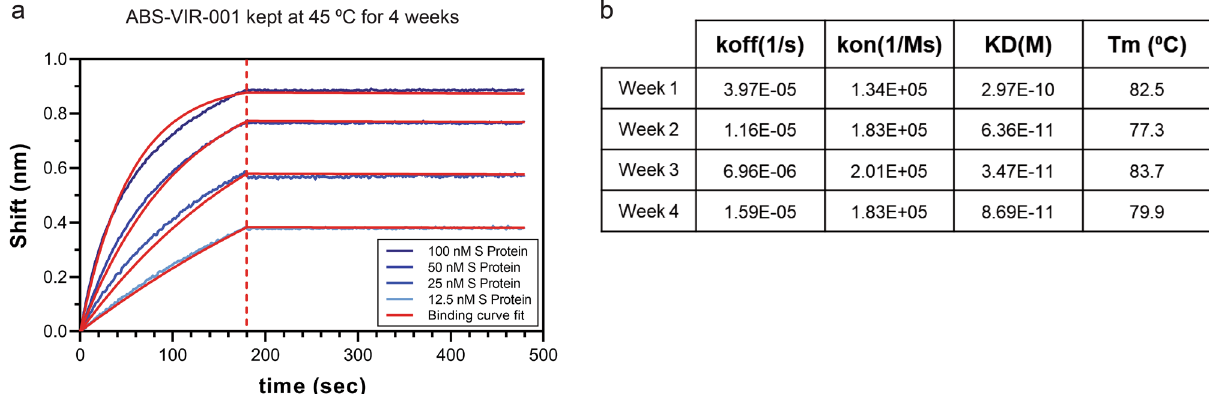
Figure 4. ABS-VIR-001 has high thermostability and aggregation resistance. ( A ) Binding kinetics graph for global KD after ABS-VIR-001 was kept at 45 °C for 4 weeks. The data was generated by the GatorPrime software (Gator Bio) v 2.7.3.0728 (https:// www. gator bio. com/), and graphed in Prism (GraphPad) software v9.2.0 (https:// www. graph pad. com/). ( B ) The weekly changes in biophysical characteristics of ABS-VIR-001 over